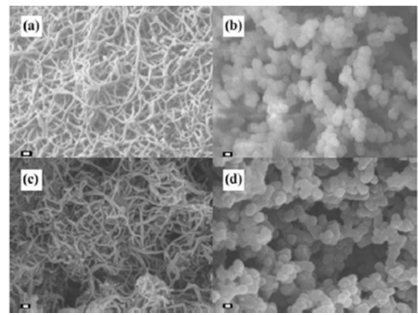
Figure 3. SEM images of ( a , b ) neat POPs and ( c , d ) metal-nanoparticle-encapsulated POPs. Reproduced with permission from [59]. Copyright 2014, Springer